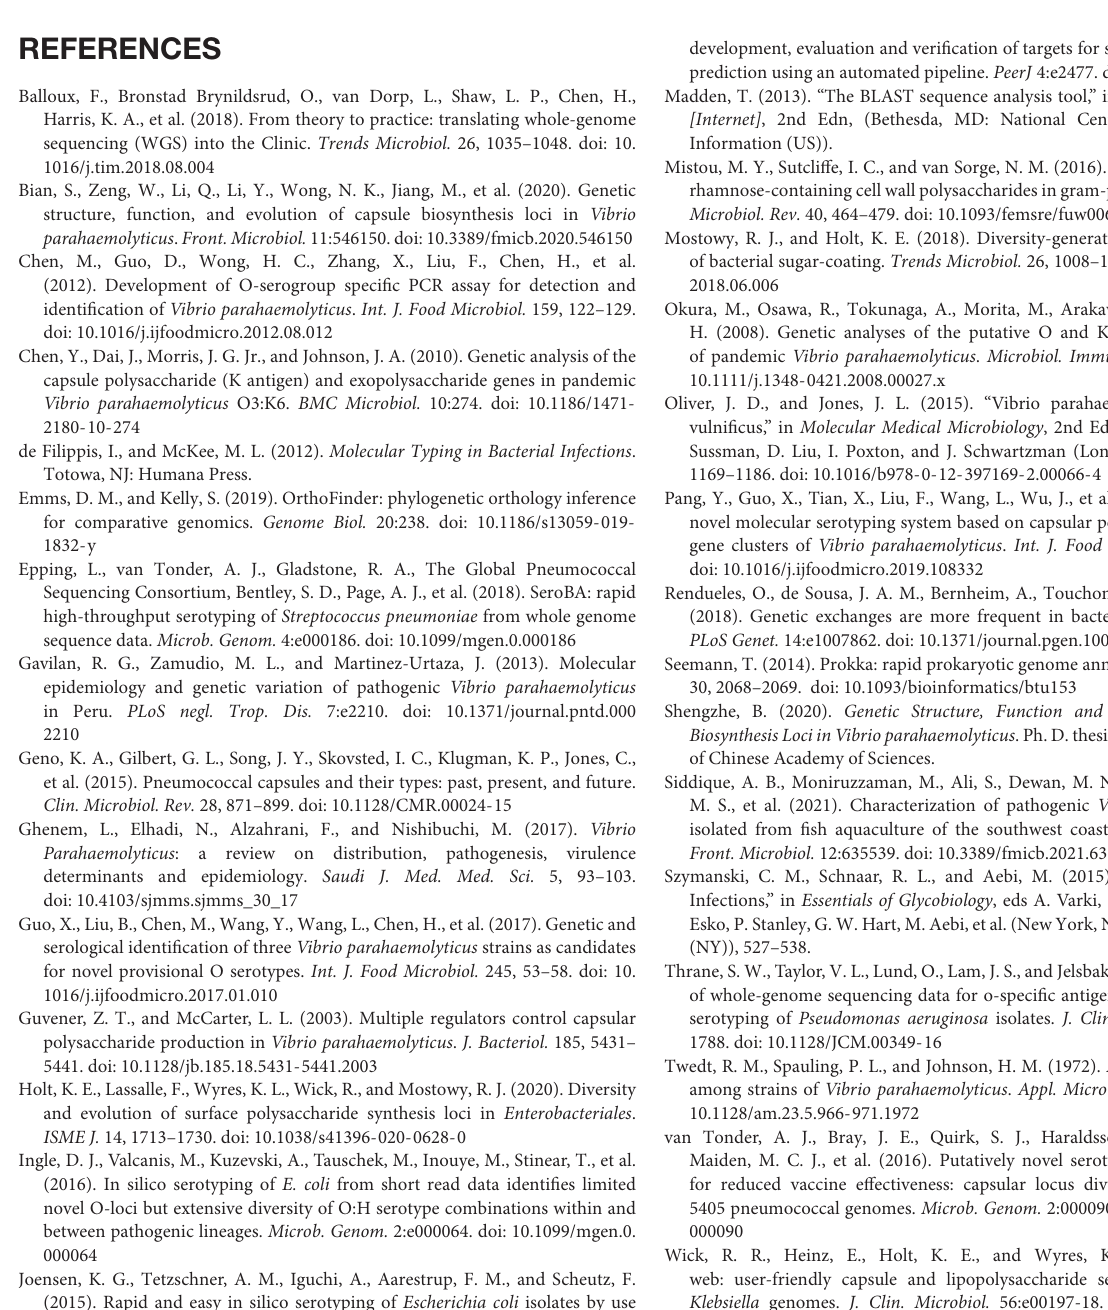
serological determination. Gene annotated as described in Supplementary Data 1 | Strains are sorted by length of CPSgc and presentation of results was manually adjusted according genetic contents similarity. Representative CPSgc strains with red and bold font are also listed for reference. Sheet1 displays the ones that can